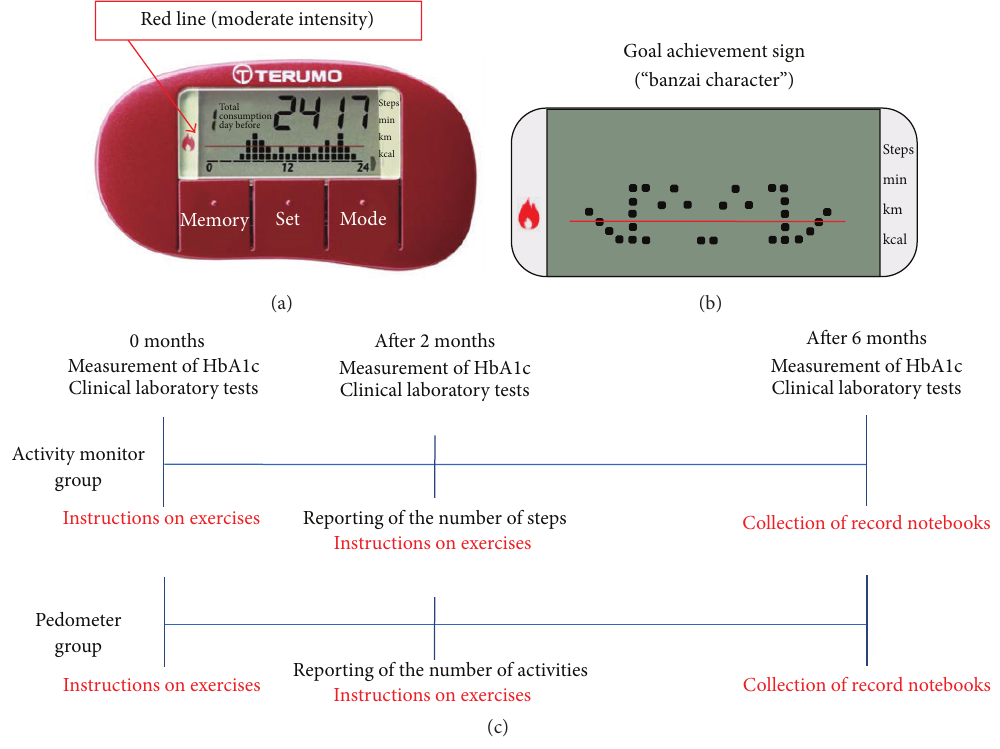
Figure 1: (a) On the activity monitor, for exercise of moderate intensity of 3 METs or higher, the intensity is displayed when the indicator exceeds the red line. (b) If the daily goal of moderate-intensity exercise of 20 minutes or longer and at least 8,000 steps is set and achieved, the user is notified that the goal has been achieved through a sign on the screen (a “banzai character”). (c) Study